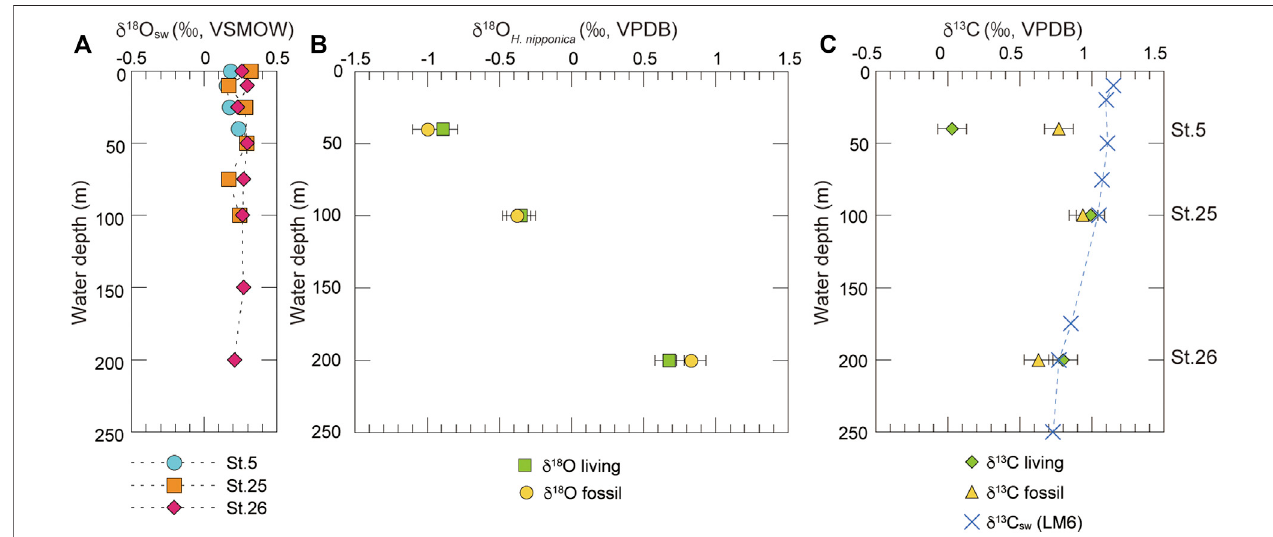
FIGURE5| Oxygenandcarbonisotopiccompositionsofseawaterand H.nipponica atthreesitesinTosaBay. (A) Verticalpro fi lesofoxygenisotopiccompositions of seawater. (B) Oxygen and (C) carbon isotopic compositions of living and fossil H. nipponica specimens. Horizontal bars represent analytical error of 0.1 ‰ . The δ 13 C